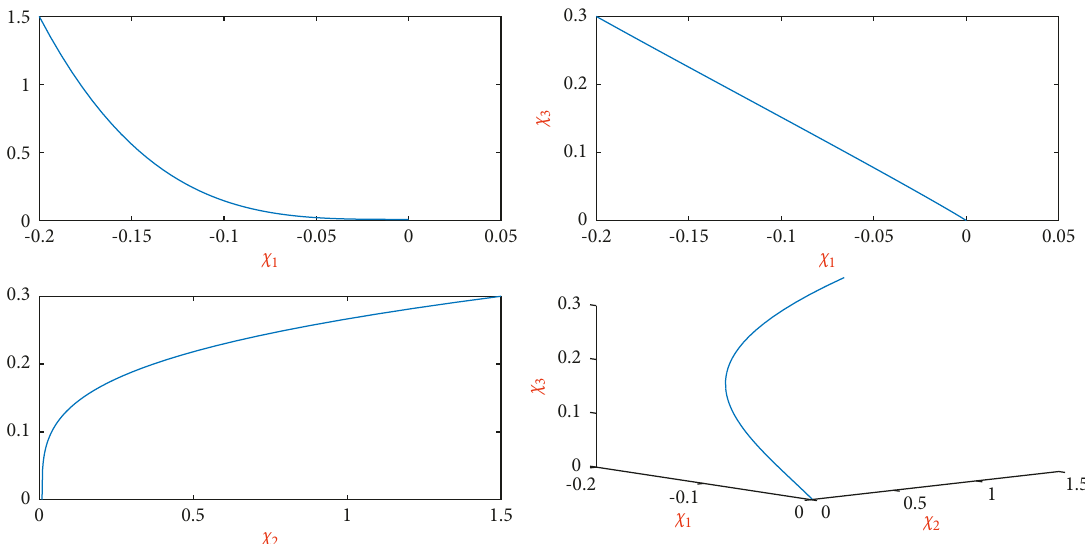
Figure 9: Scenario 6.1: a phase portrait.